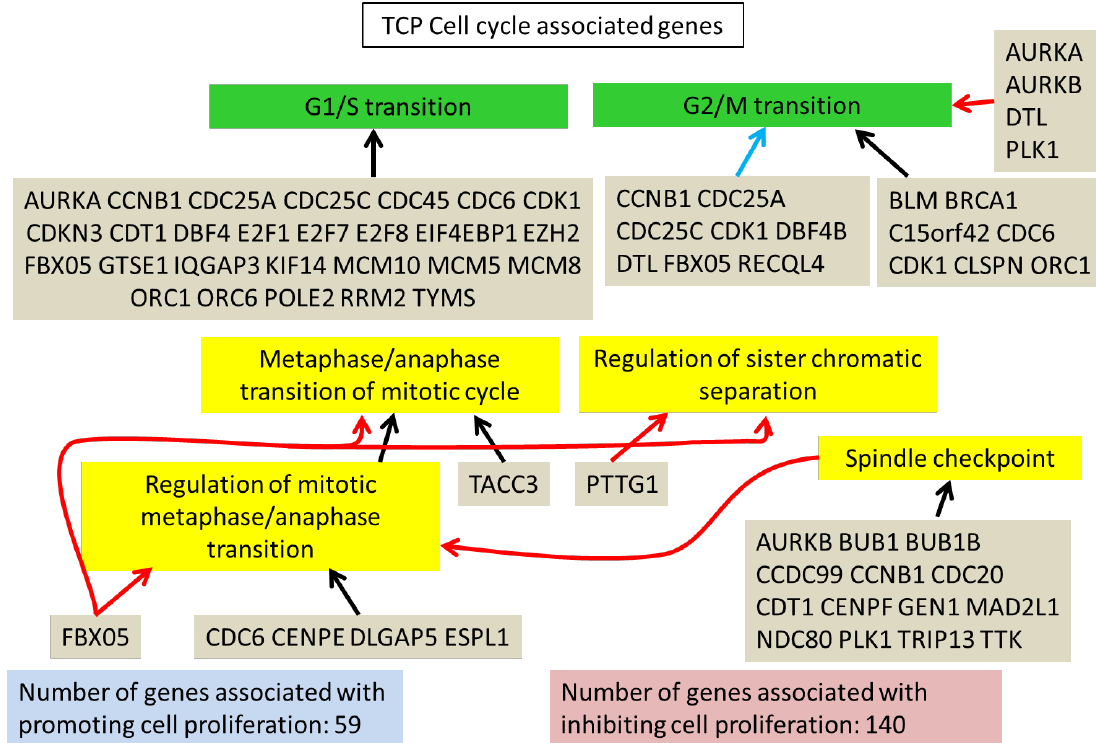
Figure 3. TCP cell cycle-associated genes. A summary of some of the cell cycle-associated genes from LAGO analysis which were upregulated in P4 chondrocytes on TCP. Similar cell cycle enrichment was seen in upregulated genes at P4 on SDECM (Figure 4). Red arrows connecting the genes to a term indicate inhibition of that term, blue arrows = promotion and black arrows = association. For the full interaction chart see S3 (TCP) and for the list of Gene Ontology (GO) terms which were significantly enriched see S5.